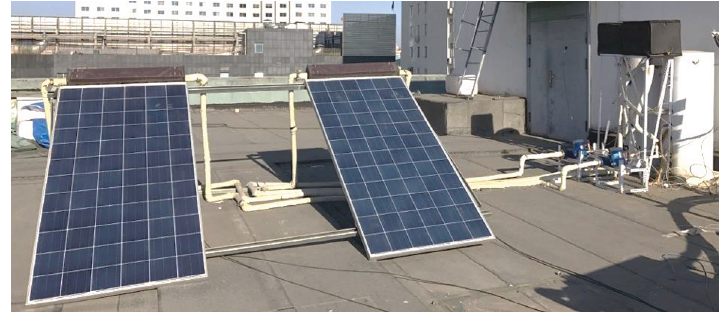
Figure 1: The testing rig of two identical heat pipe solar PV/T cogeneration systems A and B. Glass cover PV module Aluminum sheet